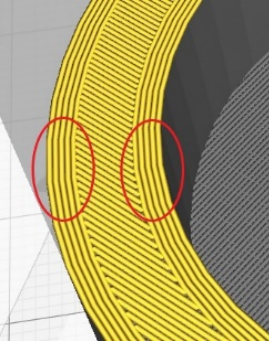
Figure 3. Outer and the inner thickness (red markers) with the cylinder body in between.